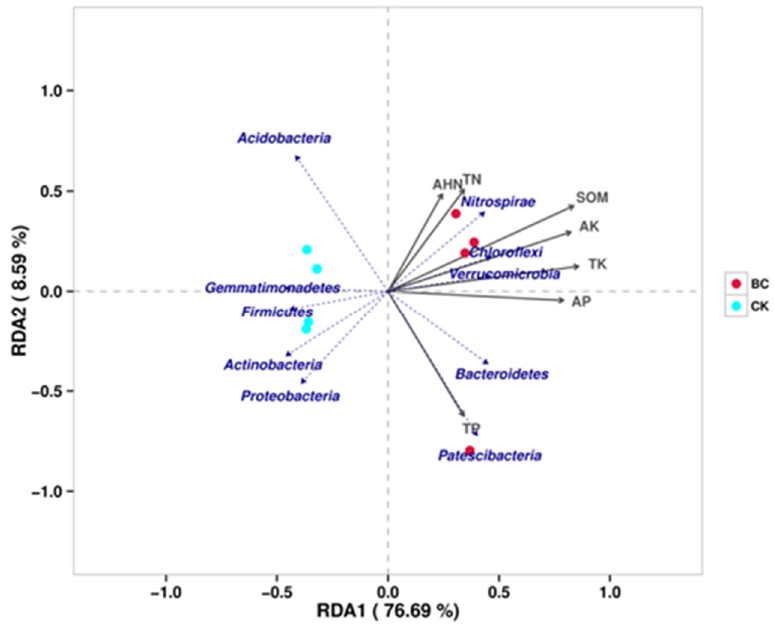
10 of 17 Figure 6. CK ( A ) and BC ( B ) bacterial community species network diagram. CK, conventional ferti- lizer; BC, biochar with conventional fertilizer. Each node represents each dominant phylum and is identified by a different color. The edge connecting two nodes indicates the correlation between two phyla, with the orange line indicating a positive correlation, and the green line indicating a negative correlation. The node size indicates the degree of association between the g phyla and other phyla of the community. The node size increases with the degree. Different colors represent different de- grees of nodes. 3.9. Correlation Analysis of Soil Bacterial Community and Soil Nutrients Based on the RDA linear model, the relationships between soil bacterial communities